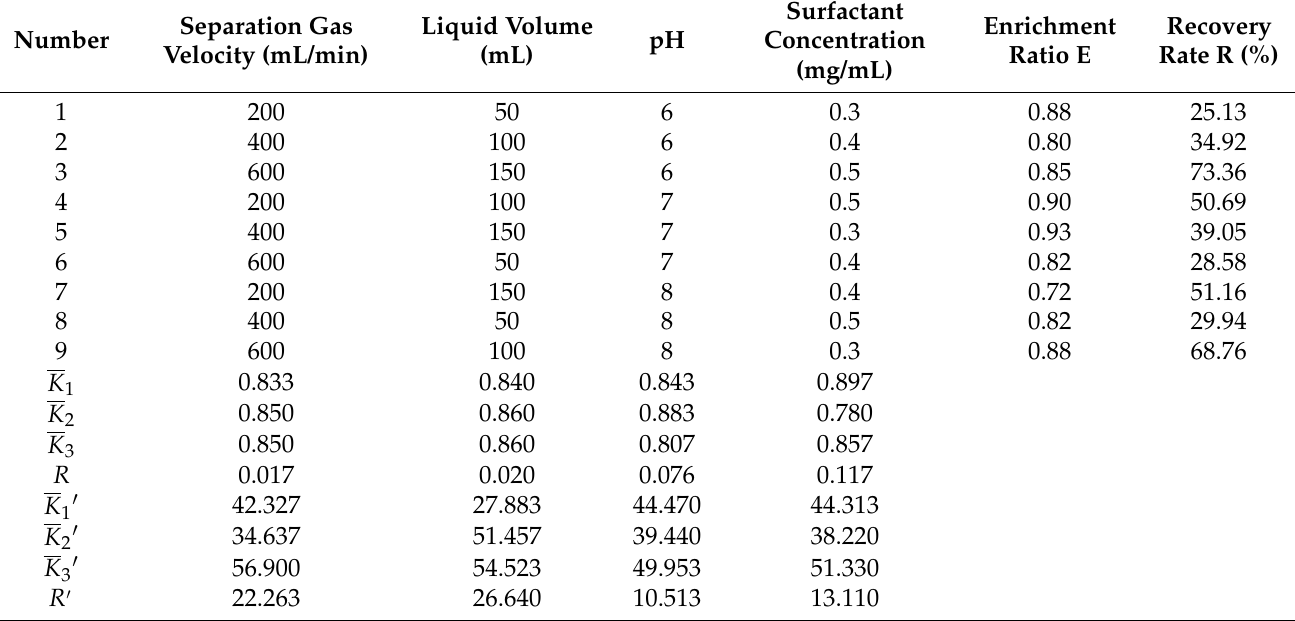
Table 2. Orthogonal experiment design and results analysis of lipase in the fermentation